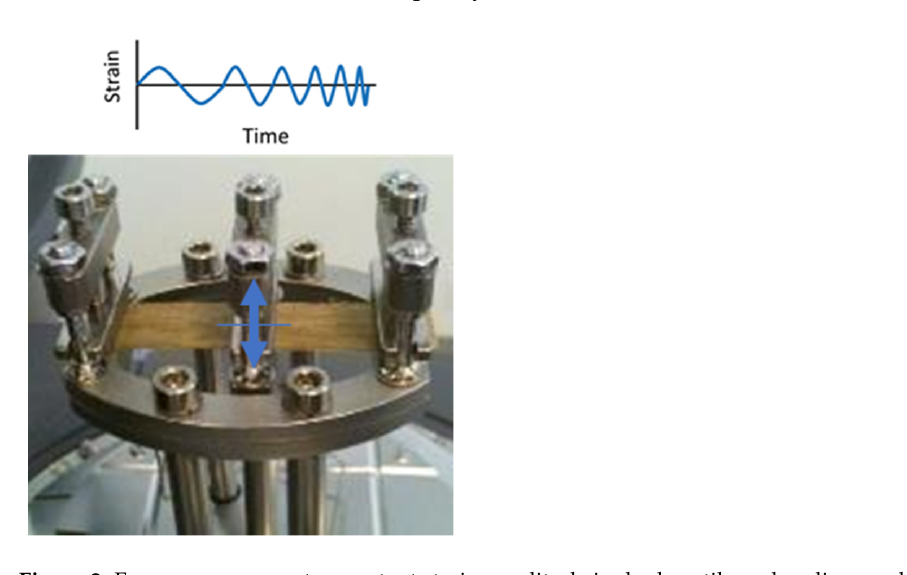
Figure 2. Frequency sweep at a constant strain amplitude in dual cantilever bending mode.